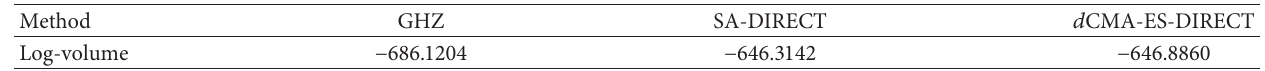
Table 8: The log-volumes of the GHZ, SA-DIRECT, and d CMA-ES-DIRECT